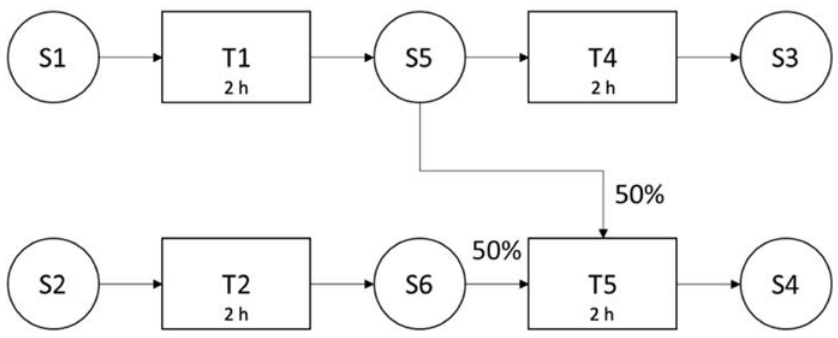
Figure 3. STN representation of the products recipe. Table 2. Unit characteristics of Example I.